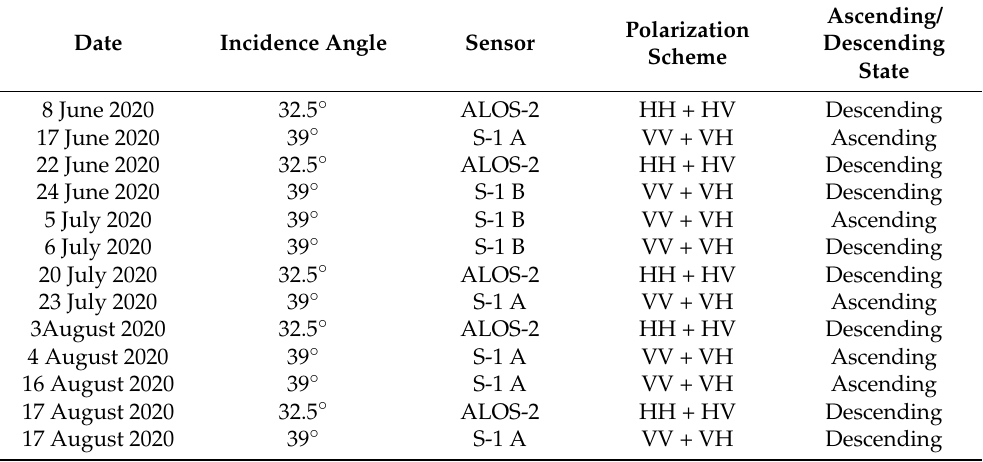
Table 1. Available synthetic aperture radar (SAR) image characteristics acquired in 2020 by Advanced Land Observing Satellite-2 (ALOS-2) in Horizontal-Horizontal (HH) and Horizontal-Vertical (HV) polarizations and Sentinel-1 A (S-1 A) and B (S-1 B) in Vertical-Vertical (VV) and Vertical- Horizontal (VH) polarizations.